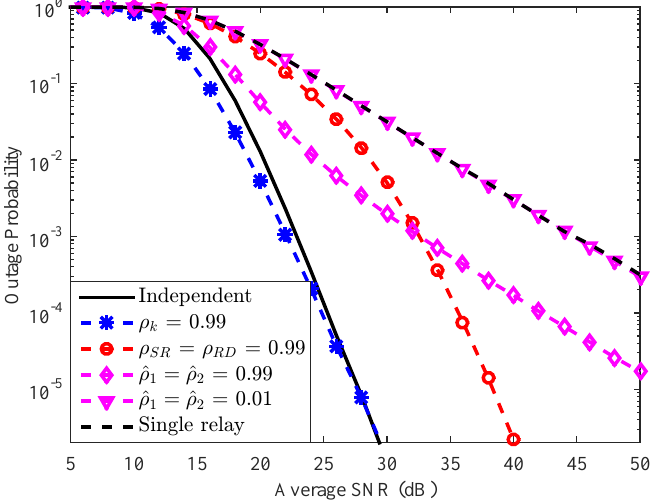
Figure 8. A comparison among the effects of several channel correlation forms on the system performance with K =